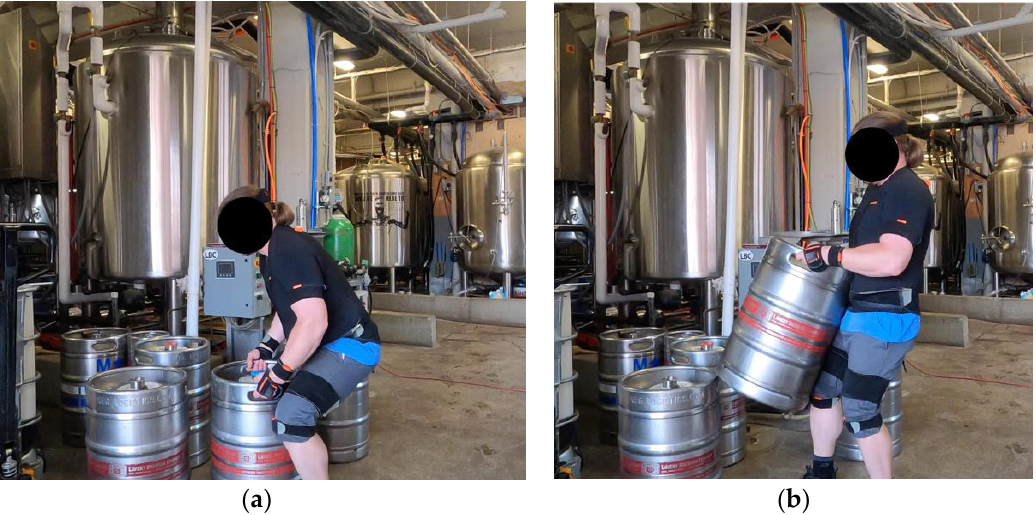
Figure 3. Task#2: Lifting a full beer keg from the floor and placing it on top of another full keg: ( a ) Pose#1; ( b ) Pose#2.